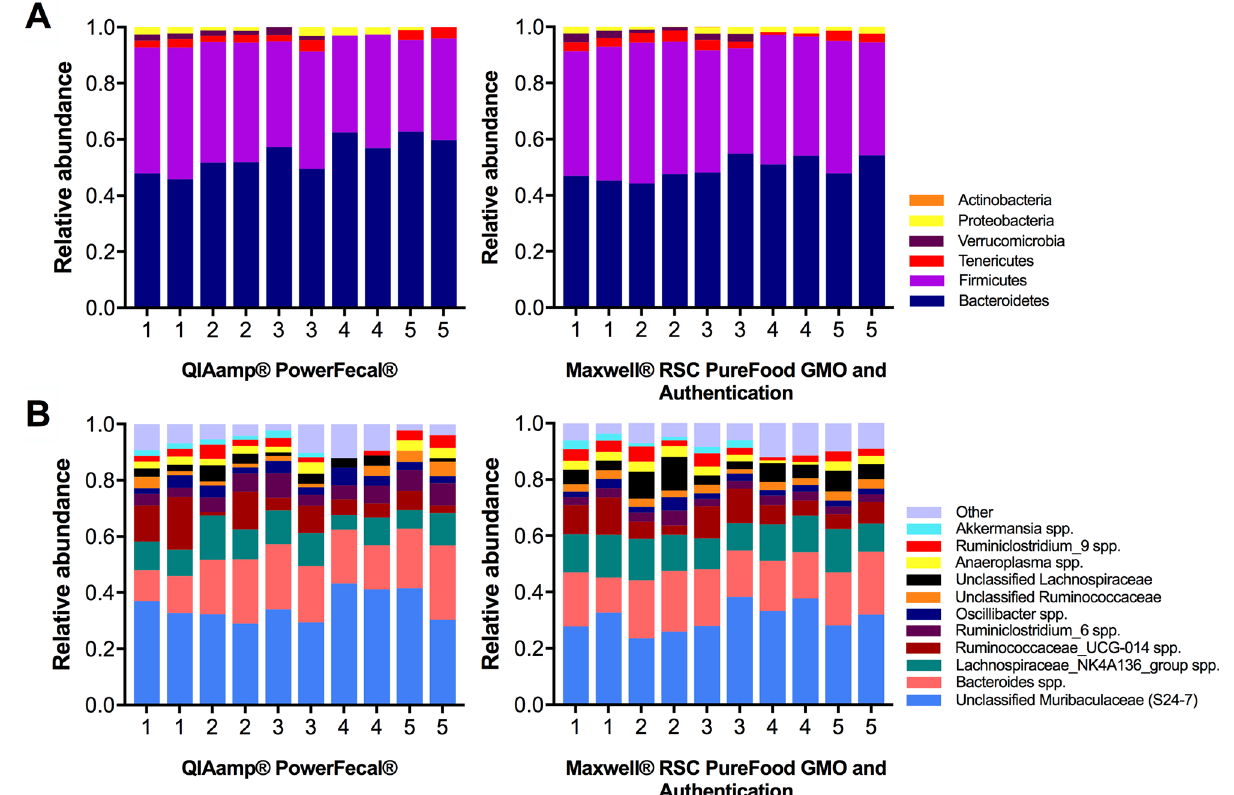
Fig 7. Comparison of relative abundance between DNA technical replicate pairs. (A) Analysis of relative abundance at the phylum level revealed similar proportions of most prominent phyla within technical replicate pairs. (B) Relative abundance of major genera was also similar when compared within and across replicate